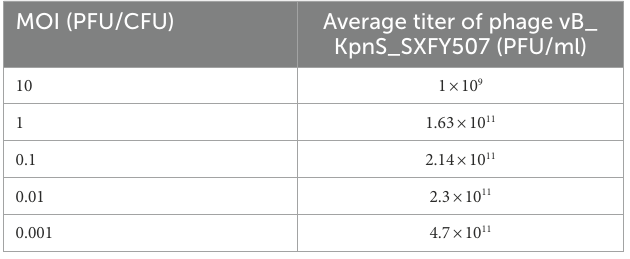
TABLE 1 Optimal MOI assays of phage vB_KpnS_SXFY507. MOI (PFU/CFU)